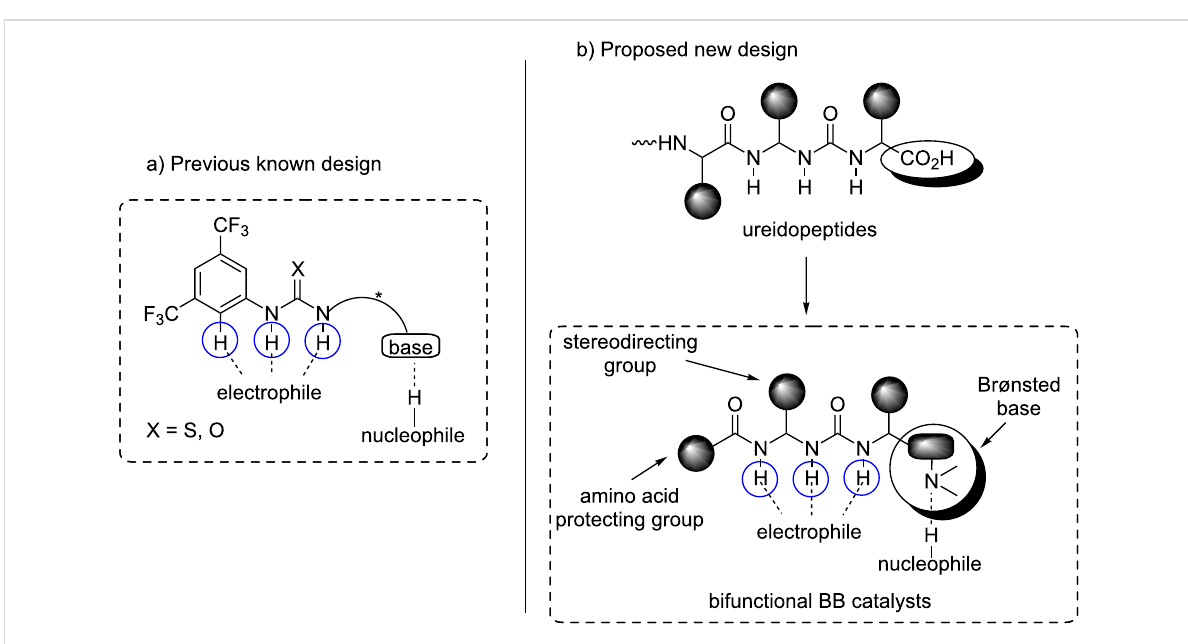
Figure 4: Ureidopeptide-like Brønsted bases: catalyst design. a) Previous known design. b) Proposed new design. BB: Brønsted base [85].